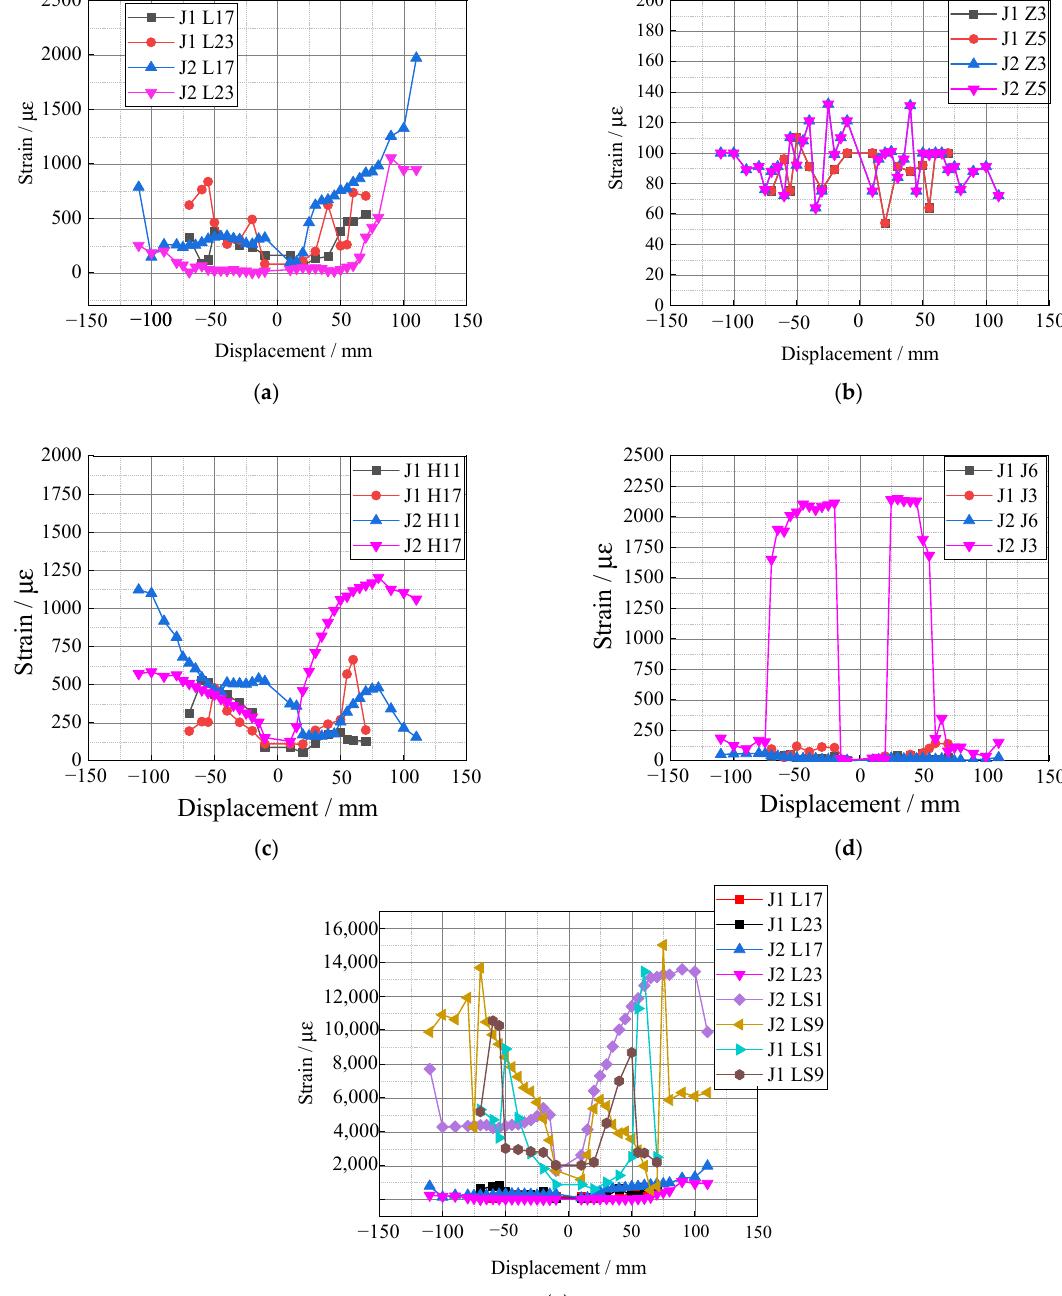
Figure 18. Specimen stress–strain. ( a ) Precast beam reinforcement strain; ( b ) precast column reinforcement strain; ( c ) concrete reinforcement strain; ( d ) haunched column reinforcement strain; ( e ) bolts in column reinforcement strain.